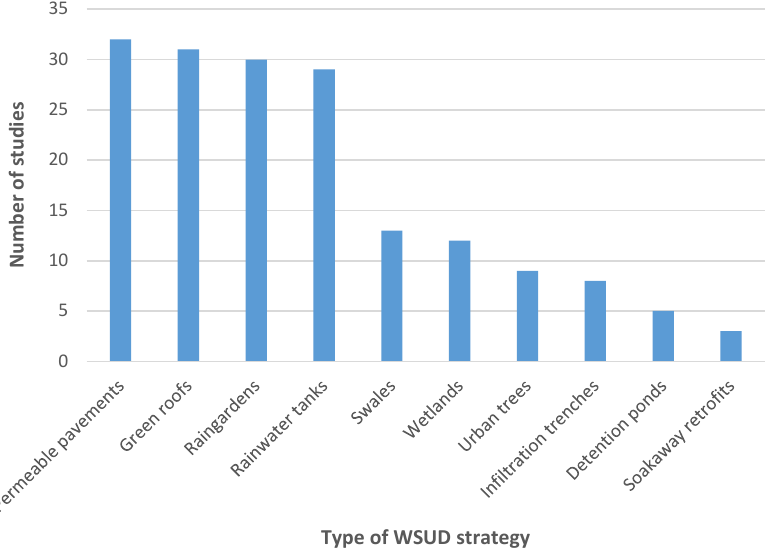
Figure 1. WSUD strategies which have been used in reviewed articles.